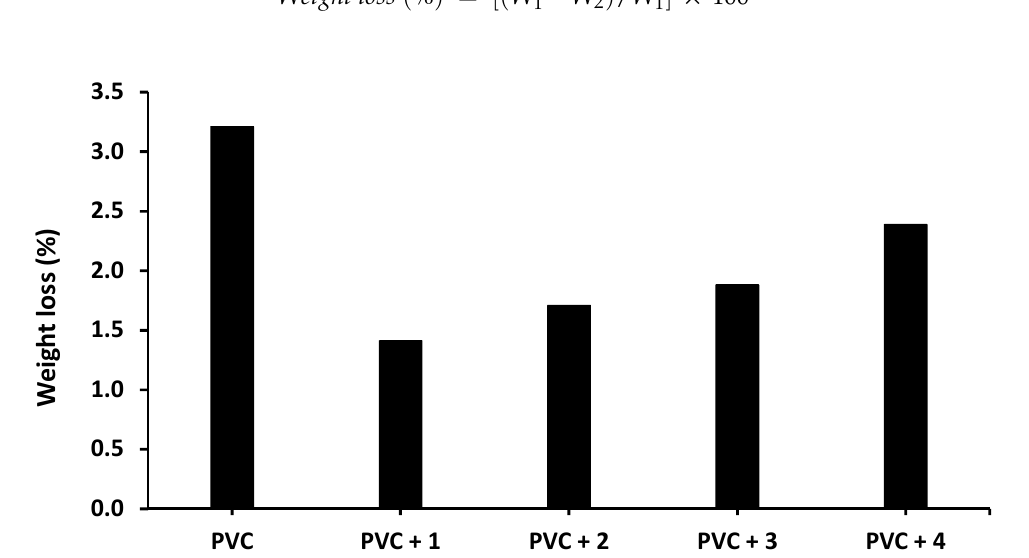
Figure 7. Effect of irradiation (300 h) on the weight loss (%) of PVC films in the absence and presence of tin(IV) compounds 1 – 4 .